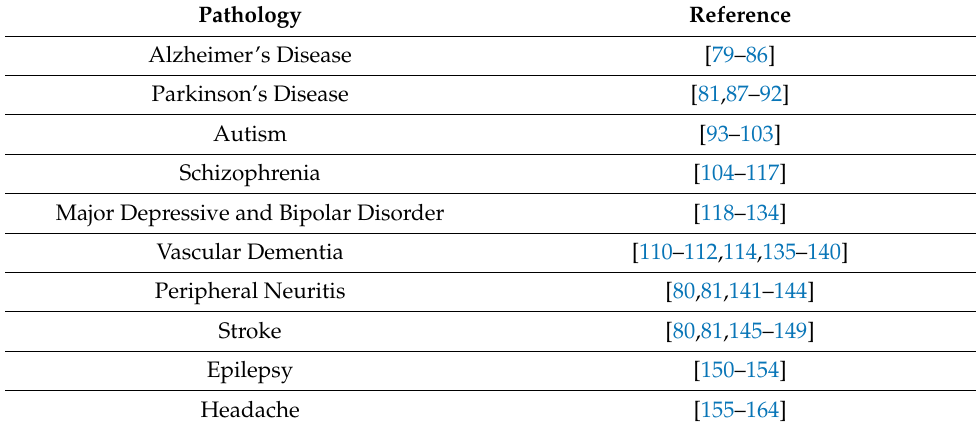
Table 1. Pathology related to high HCY levels. This table contains a recent bibliography of the most common brain disorders related to the high HCY